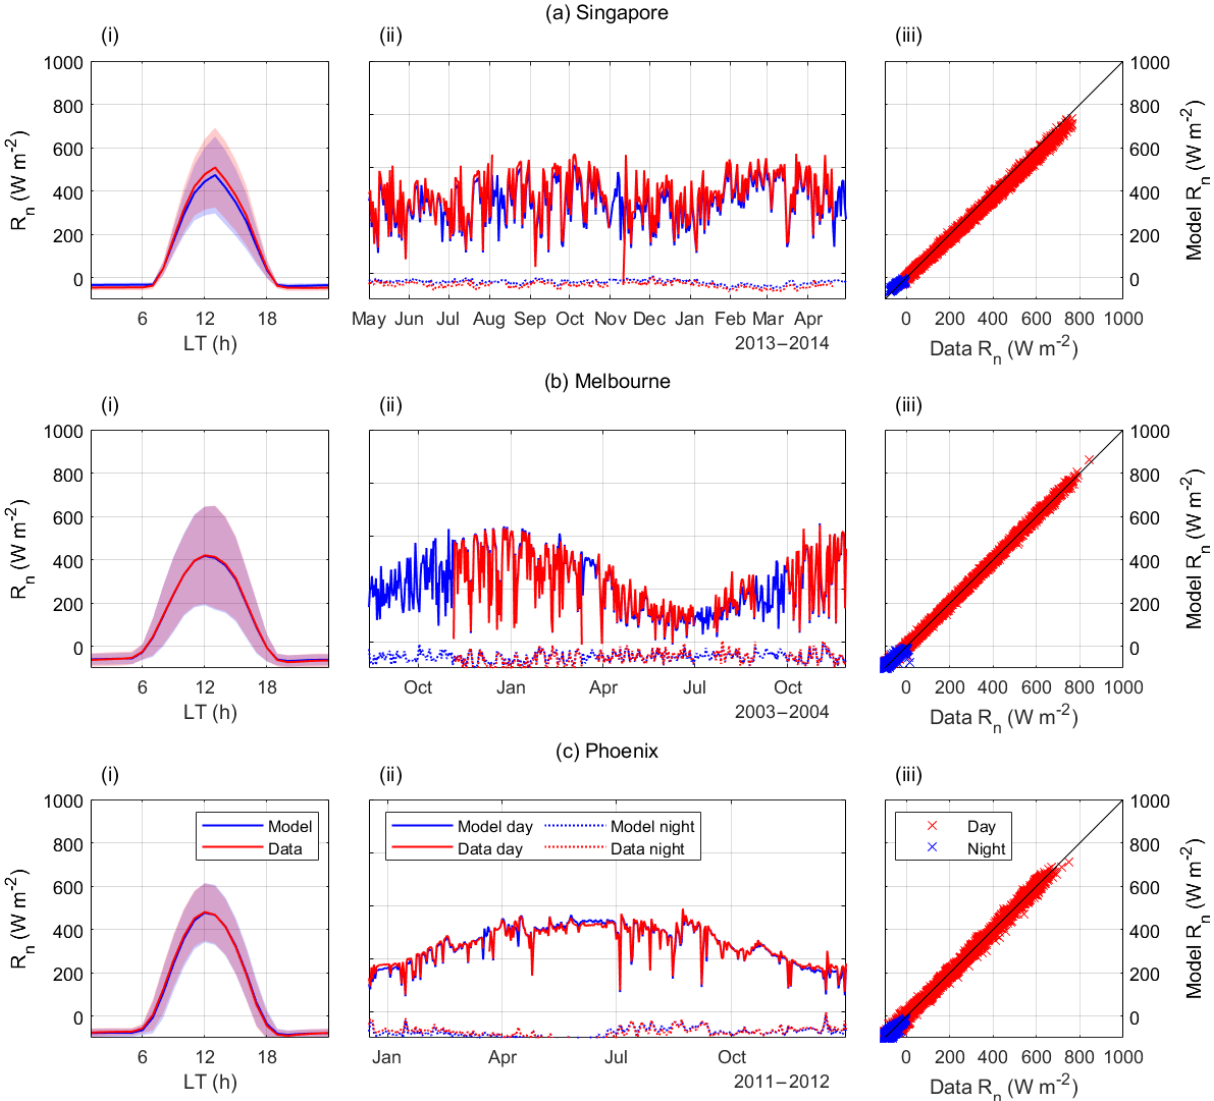
Figure 4. Comparison of modelled and measured net absorbed all-wave radiation R n for the sites in (a) Singapore, (b) Melbourne, and (c) Phoenix. (i) Average diurnal cycle (lines) ± 1 standard deviation (shaded area). (ii) Time series of mean daytime (solid lines) and nighttime (dashed lines) fluxes. (iii) Scatter plot of measurements and simulations of hourly daytime and nighttime fluxes.